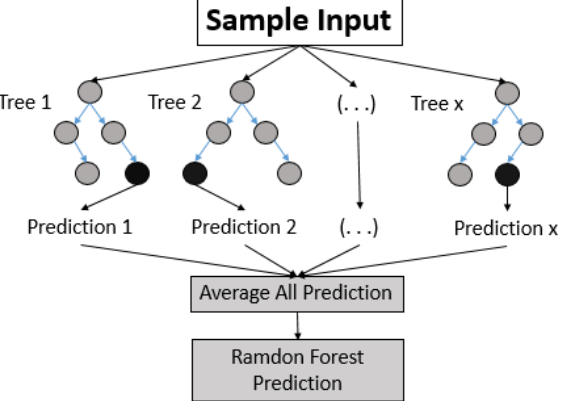
Figure 3. Representation of Random Forest